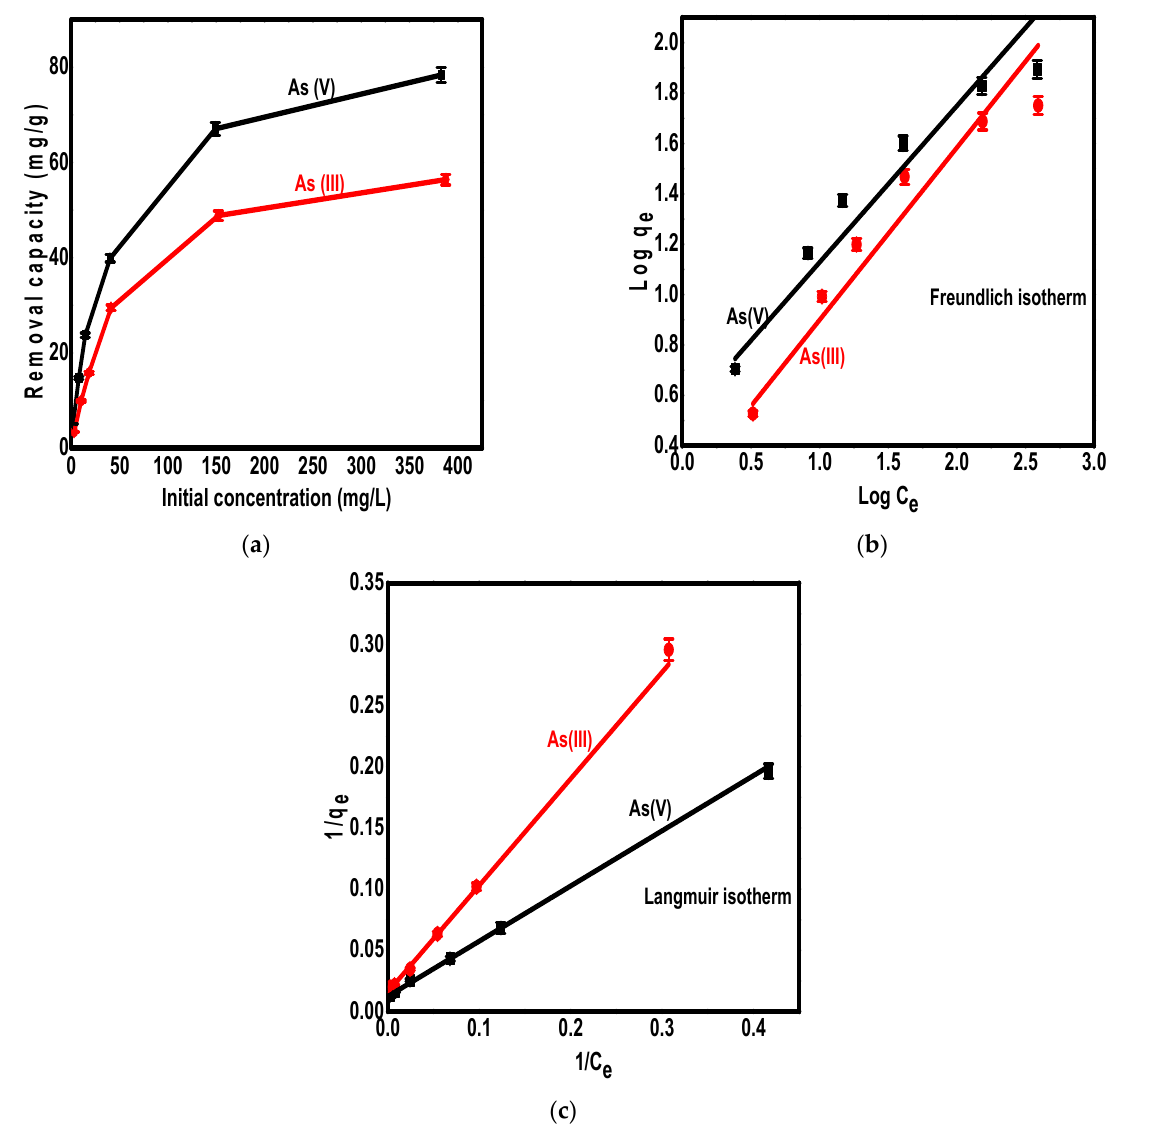
Figure 7. The arsenic initial concentration effect ( a ), Freundlich’s isotherm fitting ( b ), and Langmuir’s isotherm fitting ( c ) for the adsorption of As(III) and As(V) ions over the surface of Fe 3 O 4 /CS/PEI nanocomposite.